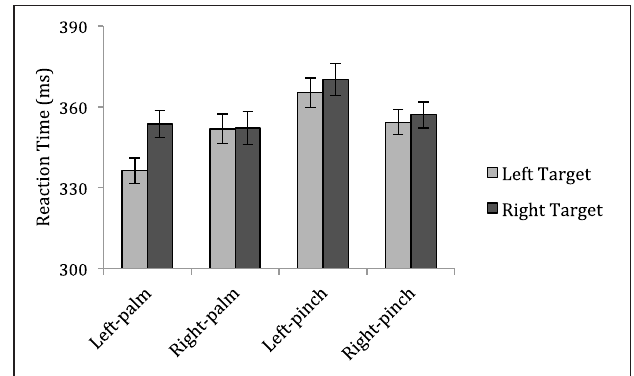
FIGURE 4 | Mean reaction times to detect targets in Experiment